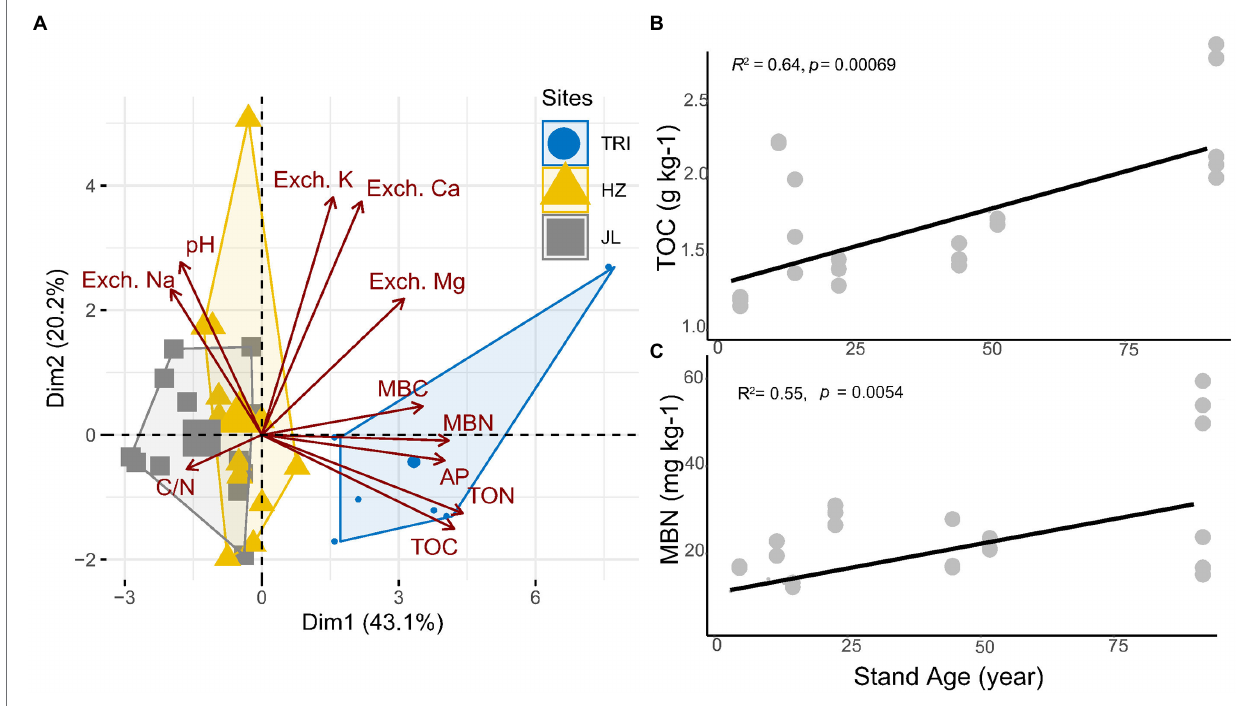
FIGURE 2 | (A) Principal component analysis (PCA) based on soil physicochemical properties as variables. The sampled tea stands from same site are outlined and grouped as the same color. (B,C) show significant linear regression ( p < 0.01) between total carbon (TOC) and microbial biological nitrogen (MBN), respectively, in the soil and the stand age across all tea